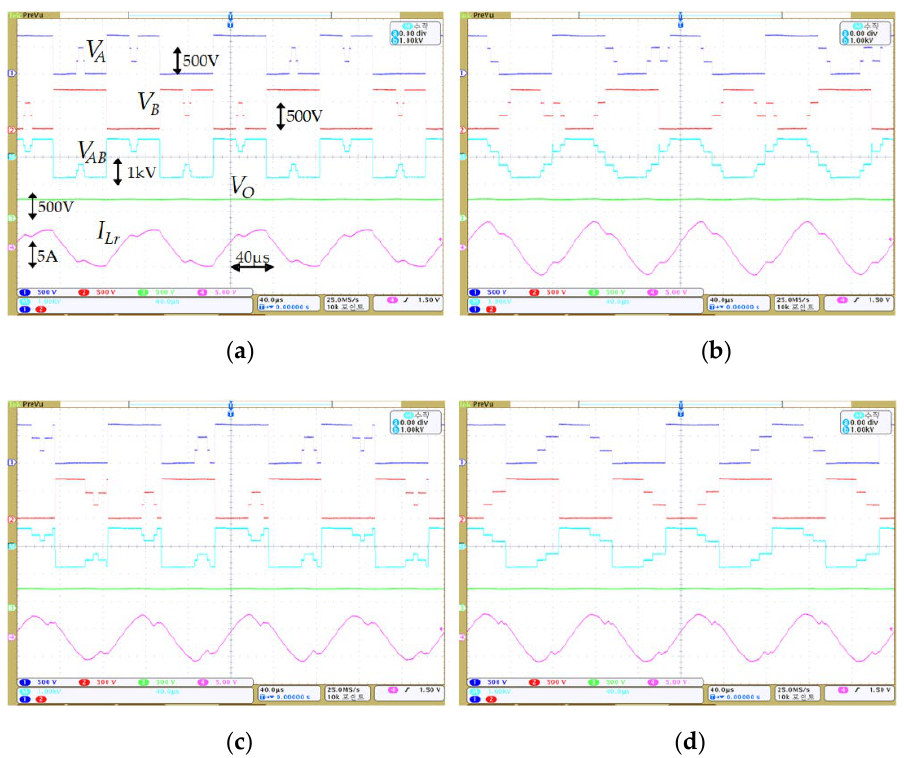
Figure 20. Experimental results for the ( a ) middle, ( b ) edge, ( c ) rear, and ( d ) end sags when P O = 1000 W.